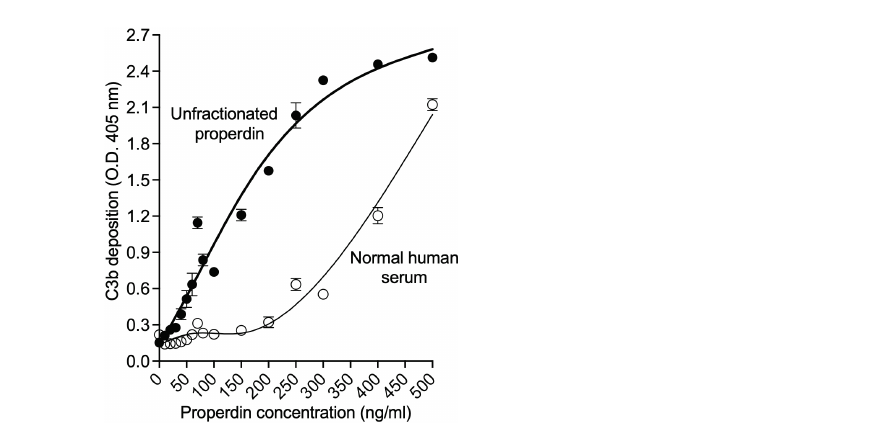
FIGURE 5 Properdin functional assay detected dose-dependent increases in properdin function and wide functional differences between samples with distinct oligomeric composition. Properdin concentration of unfractionated pure properdin and of properdin in the context of NHS was determined by sandwich ELISA as described in “ Materials and Methods ” (section 2.5), followed by assessment offunction in the samples using the properdin functional ELISA as described in Materials and Methods (section 2.8.1). Unfractionated pure properdin and properdin in NHS were assessed at varying properdin concentrations, as indicated in the x-axis. Data was graphed as mean and standard deviation of triplicates from one